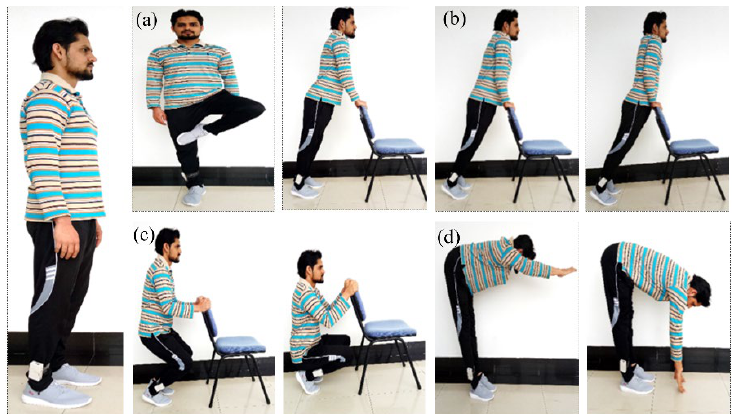
Figure 4. Classification of four different body postures performed by a male subject. ( a ) Tree posture; ( b ) leaning forward posture; ( c ) squat posture; ( d ) forward fold posture. The numbers represent the particular step of the posture.